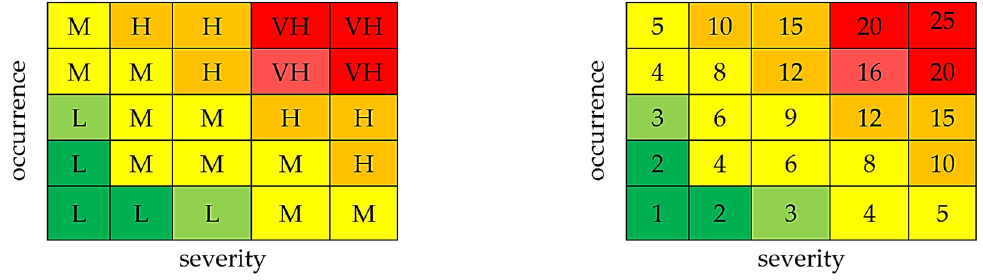
Figure 2. Criticality matrix . Table 3. Criticality analysis and its maintenance management. Table 3. Criticality analysis and its maintenance